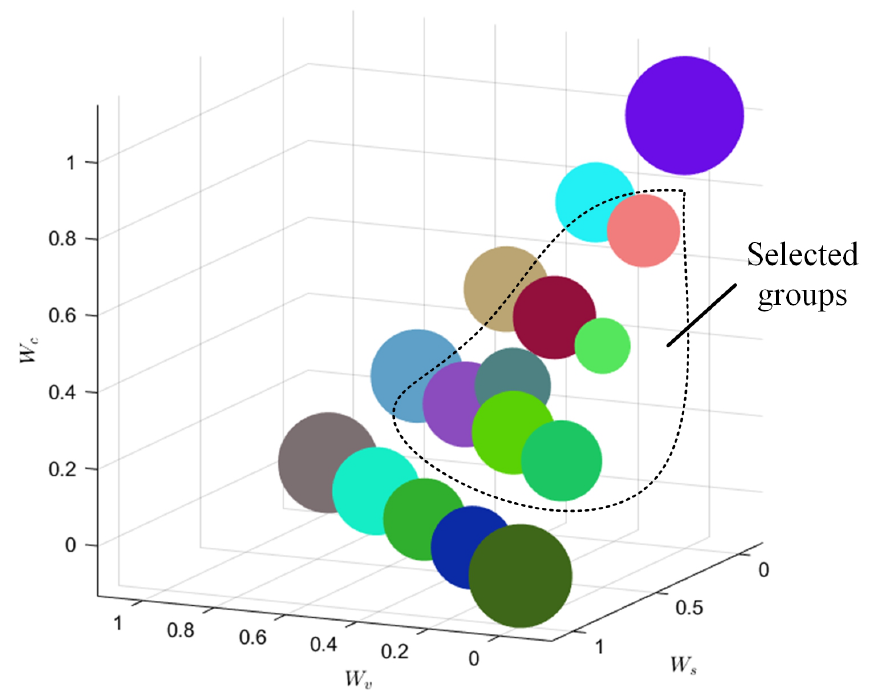
Figure 6. Test results with different objective weights are presented in different color spheres. The radius of each sphere represents the runtime to reach the coverage rate of 99%. The bigger of the sphere, the lower of the corresponding coverage